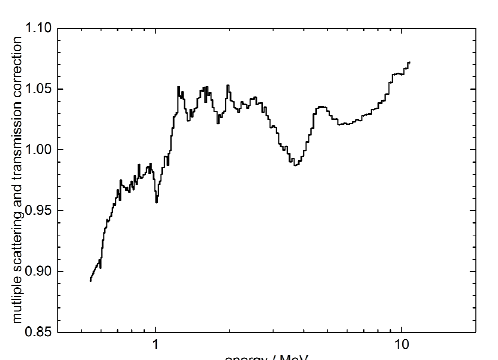
Figure 5. Correction factor accounting for neutron transmission from the fission chamber to the sample and moderation and mul- tiple scattering inside the